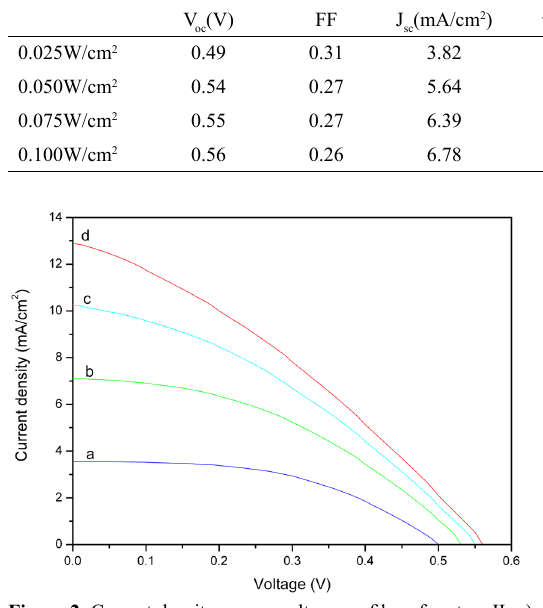
Figure 2. Current density versus voltage profiles of system II: a) 0.025 W/cm 2 , b) 0.050 W/cm 2 , c) 0.075 W/cm 2 and d) 0.100 W/cm 2 .